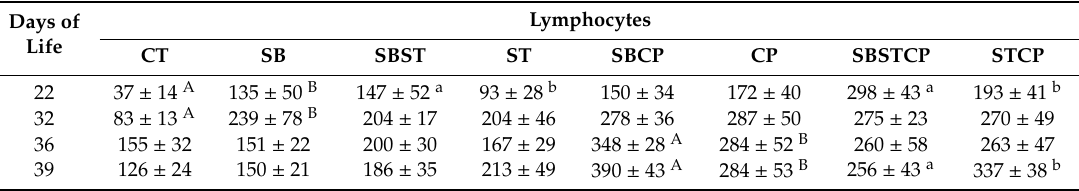
CT: control group; SB: synbiotic mix; SBST: synbiotic mix + S. typhimurium ; ST: S. typhimurium ; SBCP: synbiotic mix + C. perfringens ; CP: C. perfringens ; SBSTCP: synbiotic mix + S. typhimurium + C. perfringens ; STCP: S. typhimurium + C.